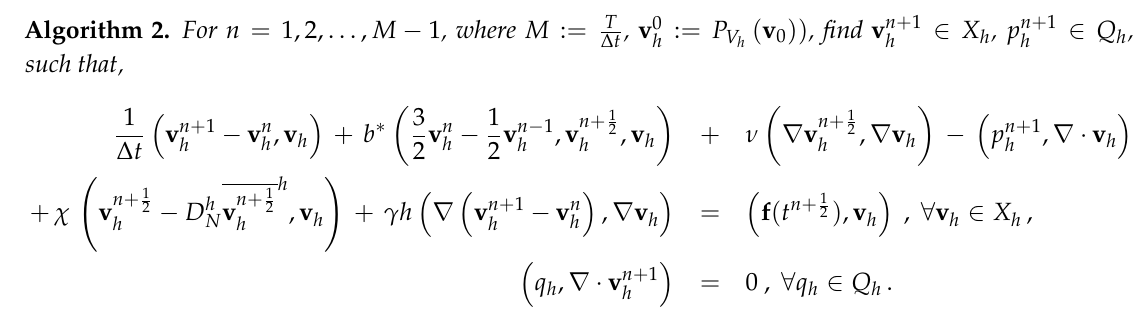
)) , find v n + 1 ( v , v 0 : = P V 0 t h h